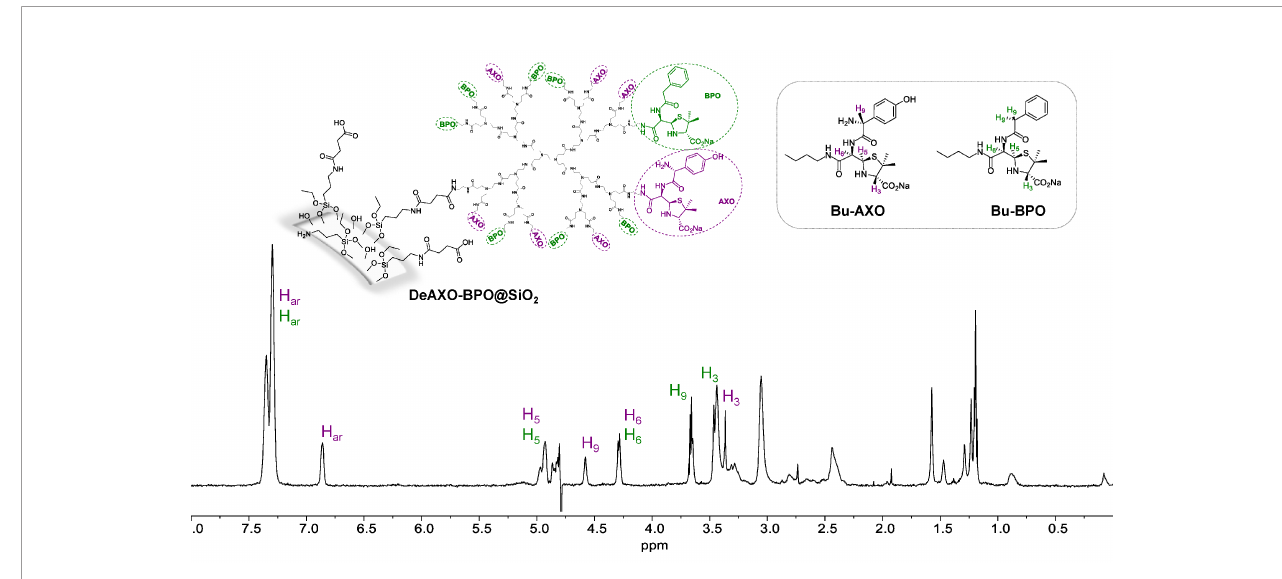
FIGURE 1 | 1 H-NMR spectra of DeAXO-BPO@SiO 2 composite (suspension in D 2 O). Inset, structures of butylamine-amoxicillin (Bu-AXO) and butylamine-benzylpenicillin (Bu-BPO) where the b -lactam ring is in its open form.